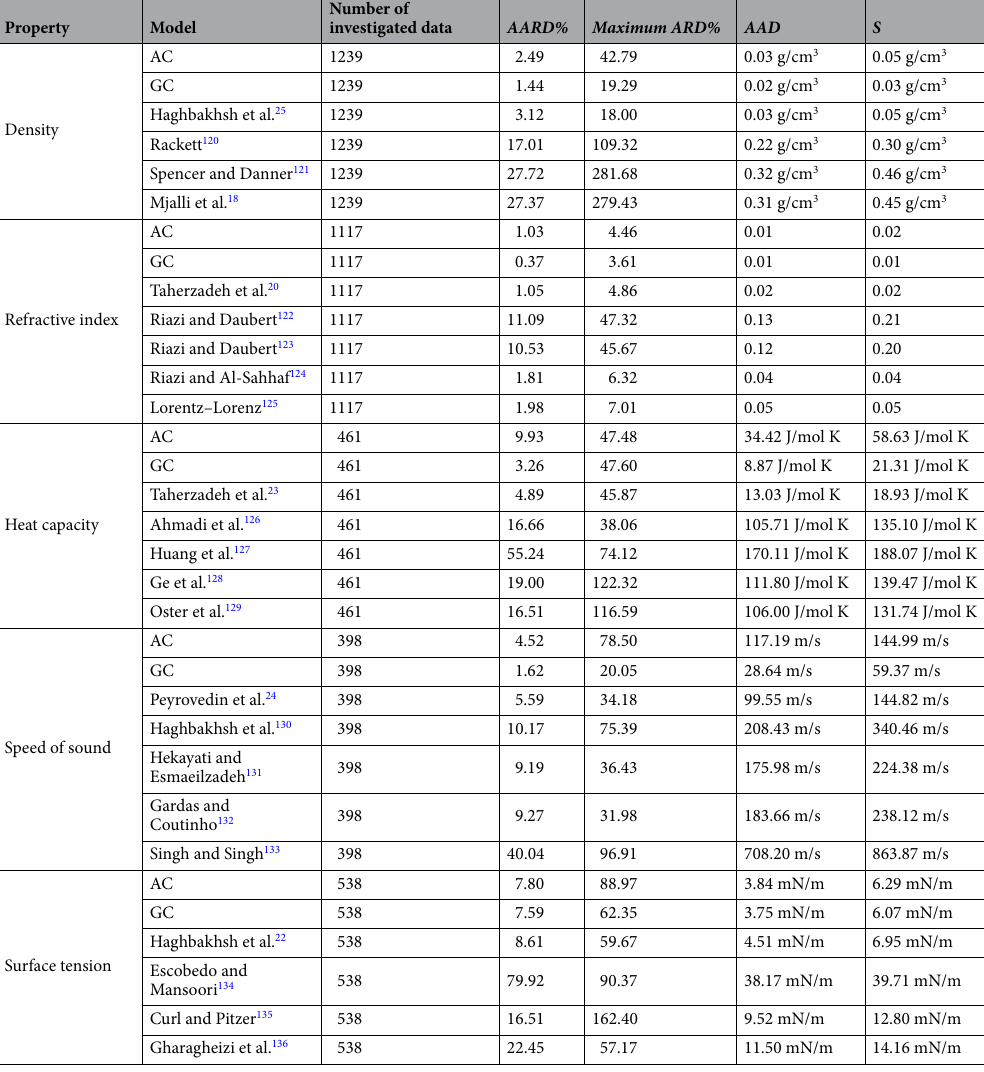
Table 4. The comparison for the calculated statistical parameters of GC, AC and literature models for density, refractive index, heat capacity, speed of sound and surface